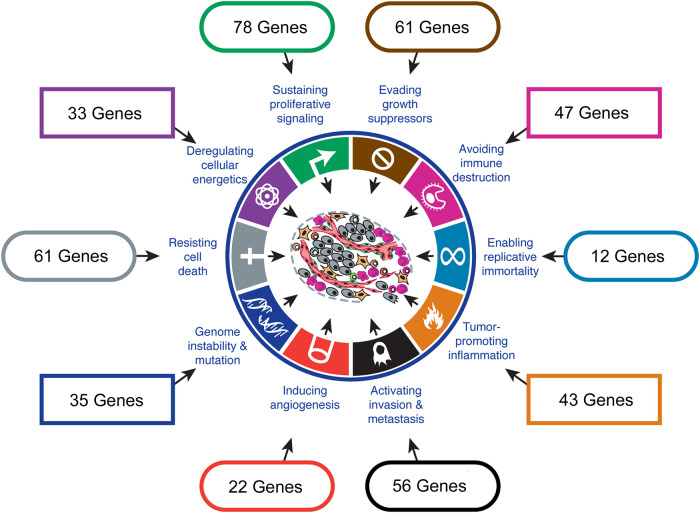
Genes associated with predicting response to neoadjuvant treatment in mRNA studies, categorized according to the Hallmarks of Cancer.Reproduced and modified with permission [75].